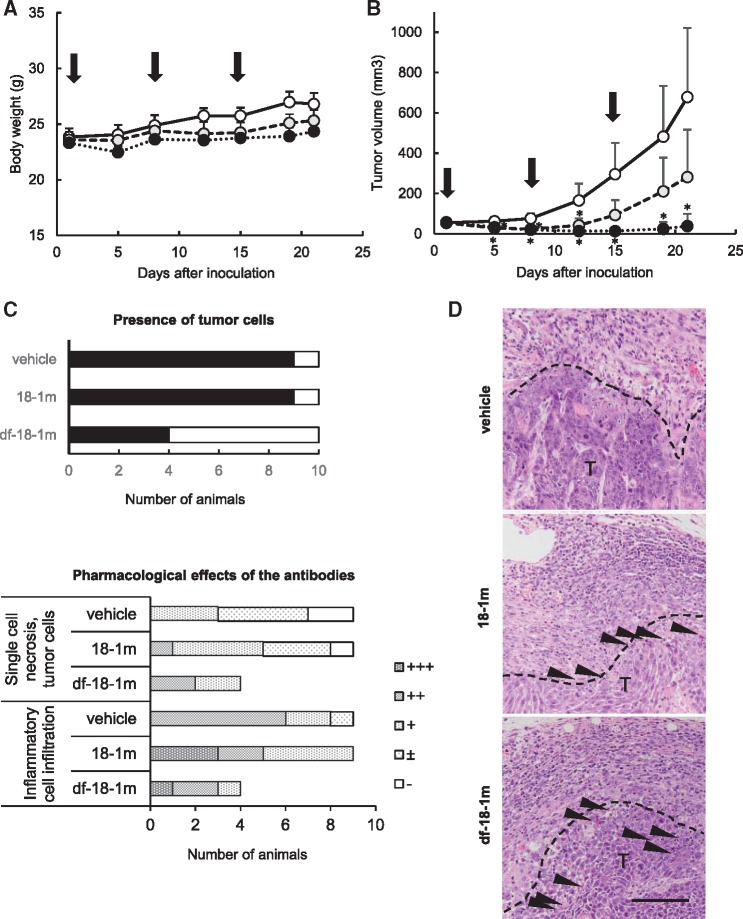

Results of anti-mouse DSG3 mAb administration in tumour-bearing Balb/c mice. Anti-mouse DSG3 mAb 18-1m and df-18-1m were inoculated at 10 mg/kg in LC12 syngeneic mouse model. Days of treatment with mAb are shown by arrows. (A) Body weight change. (B) Tumour volume change. The mean for each group is shown for each time point. Bars indicate standard deviation of the mean. White circle, control; grey circle, 18-1m; black circle, df-18-1m. *P < 0.05, compared with vehicle. (C) Histological examination of engrafted LC12 tumours. The presence of tumour cells in the site of engraftment (upper left). Closed square, present; open square, absent. Changes related to the pharmacological effects of the antibodies (lower left) are shown by severity of change: ±, very slight; +, slight; ++, moderate; +++, severe. (D) Representative images of tumours in each group. Increased inflammatory cell infiltration and single-cell necrosis (arrow heads) were observed in antibody administered tumours. The changes were noted around the interface (broken line) of the tumour mass (T) with surrounding tissue. Bar = 100 µm.